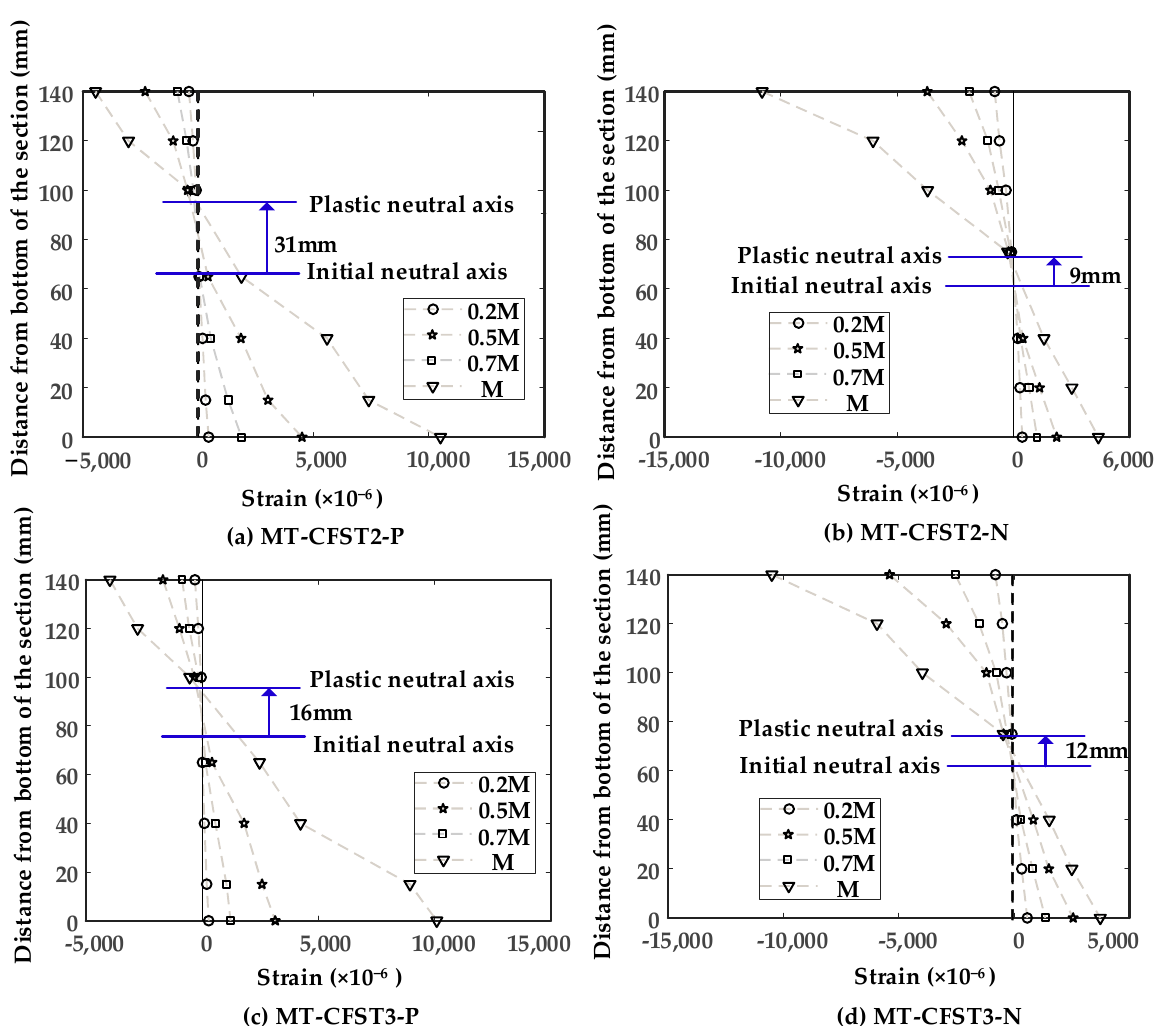
Figure 10. Measured strain distributions for MT-CFST specimens: ( a ) MT-CFST2-P; ( b ) MT-CFST2-N; ( c ) MT-CFST3-P; ( d ) MT-CFST3-N.